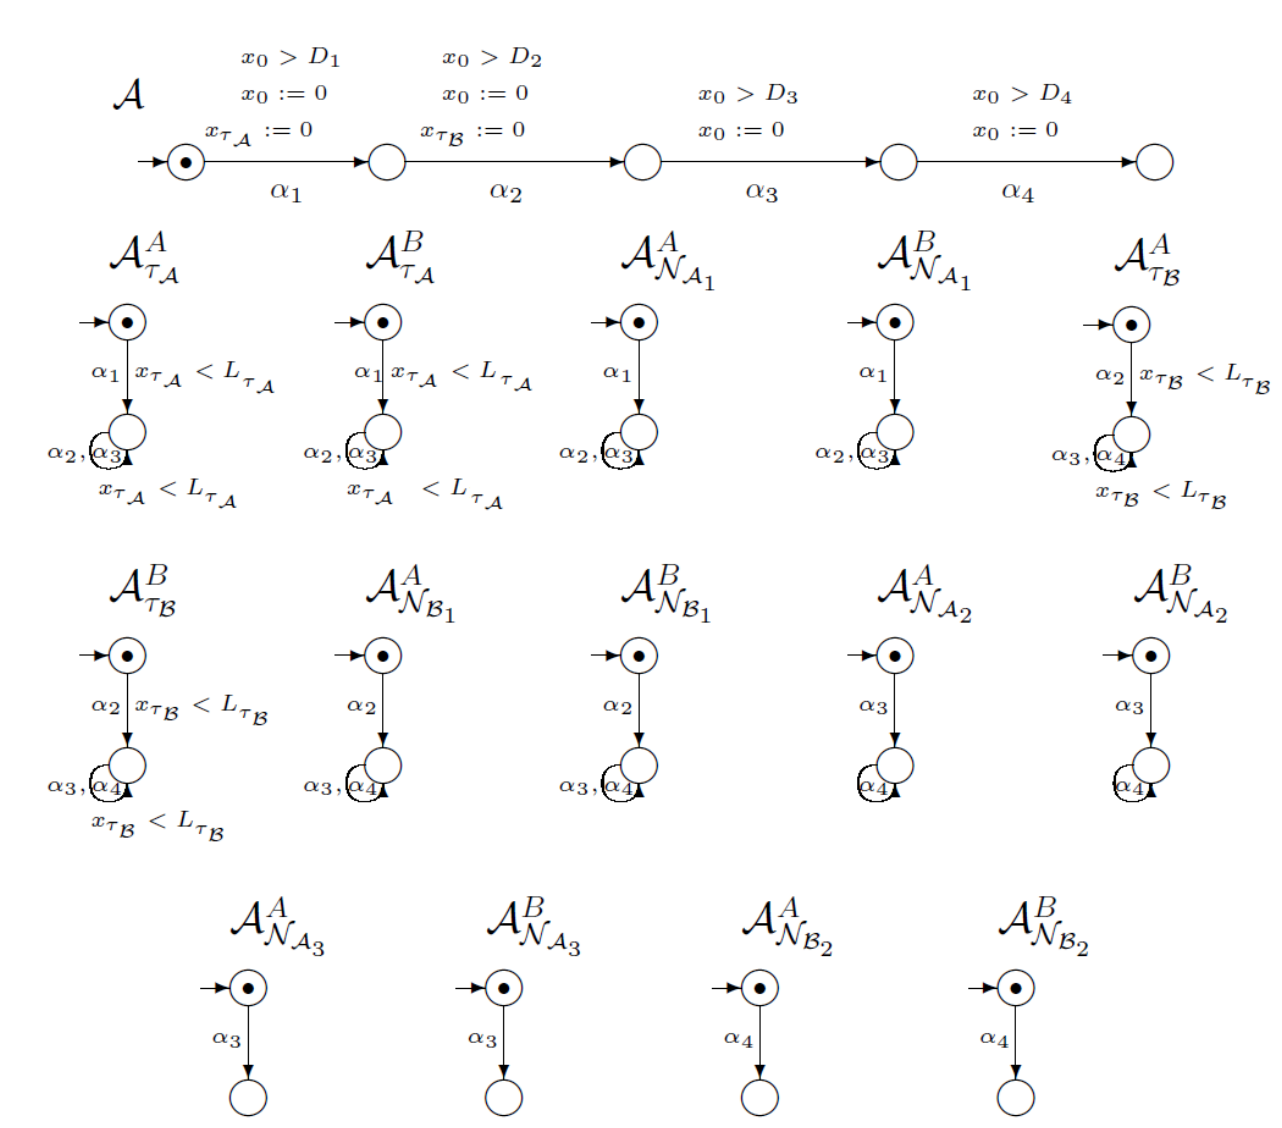
Figure 7. Network of synchronised timed automata for SNEP protocol